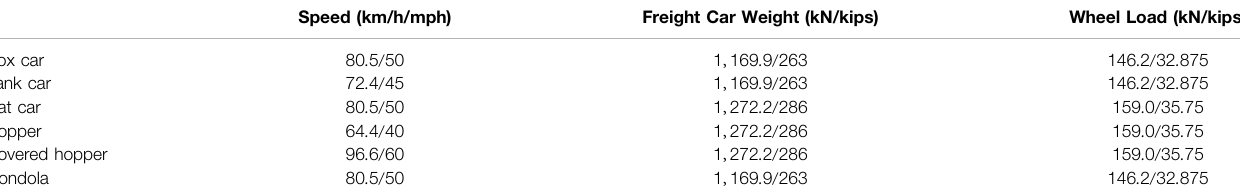
TABLE 1 | Parameters of freight trains passage.